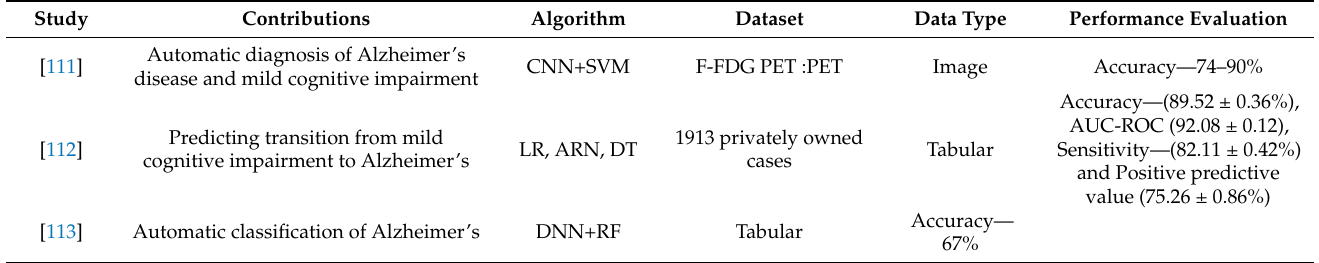
Table 9. Referenced literature that considered Machine Learning-based Alzheimer disease